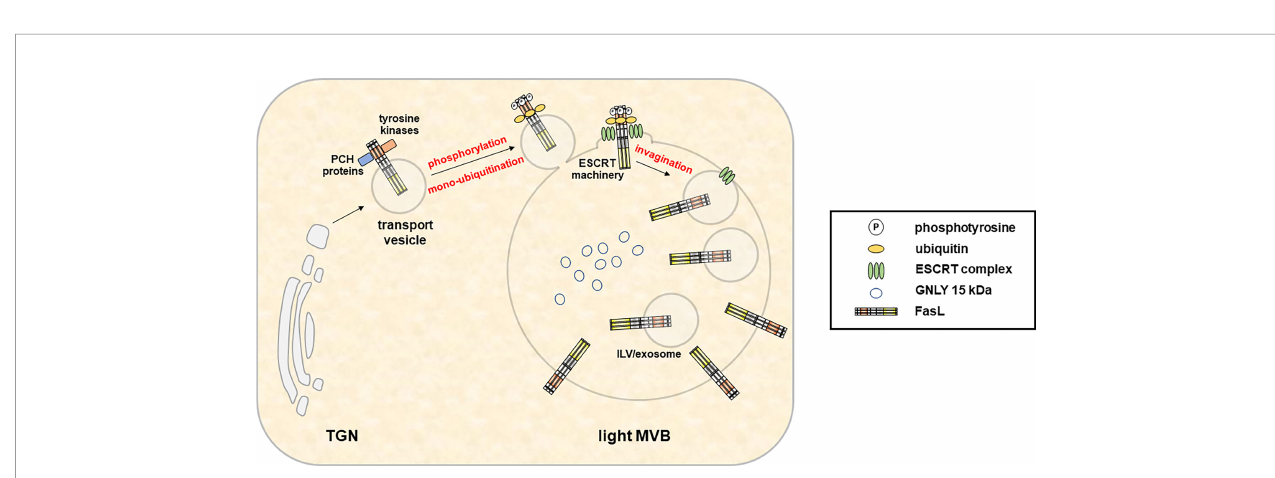
FIGURE 3 | In hematopoietic cells, the type 2 transmembrane death effector FasL is sorted to intracellular MVB for storage and regulated release in response to appropriate stimuli. Fusion of the FasL-MVB with the plasma membrane results in the local exposure of FasL molecules present in the MVB outer membrane on the cell surface. Moreover, FasL localized in the membrane of ILV is released in association with exosomes. An extended proline-rich domain within the FasL cytoplasmic domain enables interactions with PCH proteins and Src kinases and is required for the sorting to MVBs. In addition, FasL localization also depends on phosphorylation of intracellular tyrosines. However, the exact sorting mechanisms and subcellular localizations of protein interactions and phosphorylation events are not de fi ned yet. Subsequently, mono-ubiquitination of the FasL at intracellular lysines enables its sorting to ILV by the ESCRT machinery.